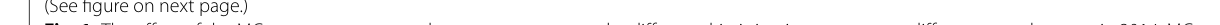
Table 1 Significance ( P -values) of drip irrigation amounts and MC different growth stages in 2014 Source of